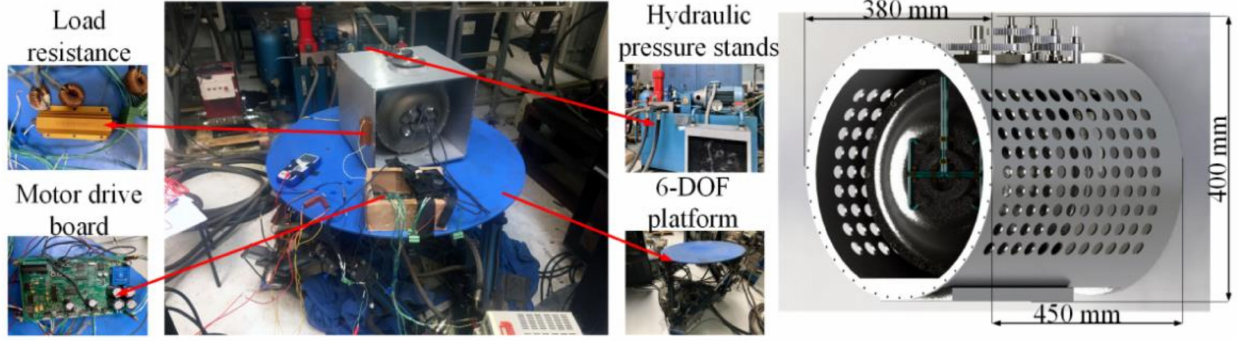
Figure 4. 6-DOF platform